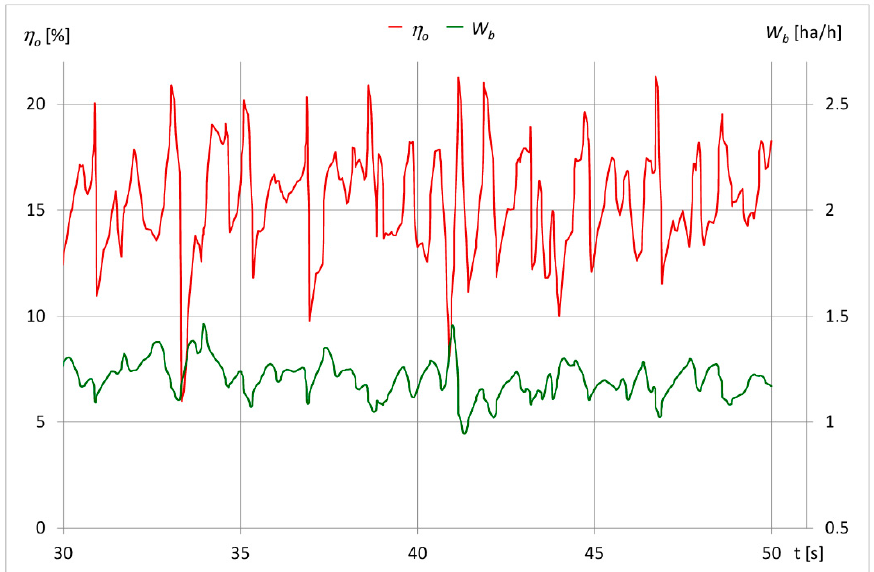
Figure 12. Changes in total efficiency η o and area productivity W b of the tractor unit in the third gear, soil profile—medium clay, and depth setting a nS 2 = 0.19 m.